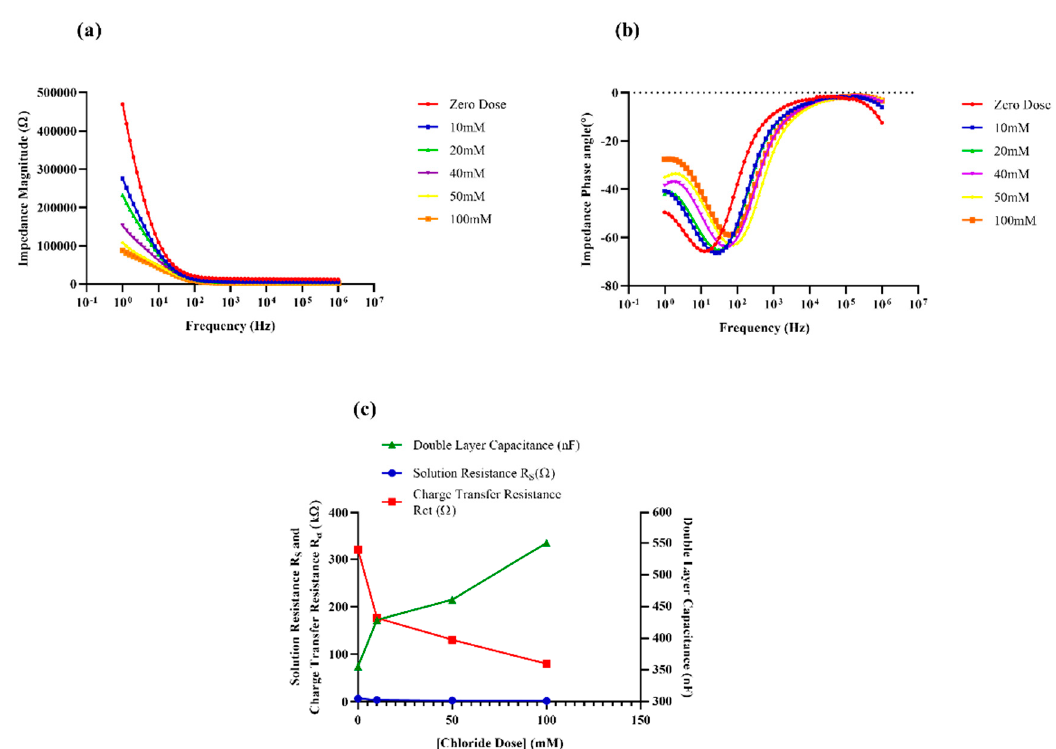
Figure 4. ( a ) Bode magnitude and ( b ) Bode phase plots obtained from non-faradaic electrochemical impedance spectroscopy (EIS) measurements for 1 Hz to 1 MHz range. Equivalent circuit parameters for the circuit corresponding to chloride dosing (Figure 2) were extracted for χ 2 ~0.001 are shown in ( c ).